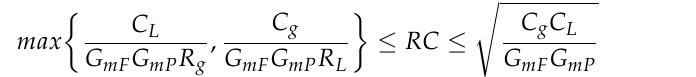
By replacing the LDO inner feedback loop with its closed ‐ loop equivalent (3), one obtains the LDO model shown in Figure 4b. This is also a multiple ‐ loop circuit, with the loop closed around the LDO fast core being the inner ‐ most loop in this case. A second topological transformation is necessary to replace the entire section denoted by “CORE FEEDBACK LOOP” in Figure 4b with its equivalent closed ‐ loop circuit, shown in Figure 4c. The core feedback loop has a series ‐ parallel topology, with unitary feedback transmittance. Therefore, the equivalent closed ‐ loop circuit has the voltage–voltage gain Avv CORE = T CORE , while 1 + T CORE its input and output impedances are obtained by multiplying, respectively dividing, by the factor ( 1 (cid:3397) (cid:1846) (cid:3004)(cid:3016)(cid:3019)(cid:3006) (cid:4667) , the input/output impedances of the open ‐